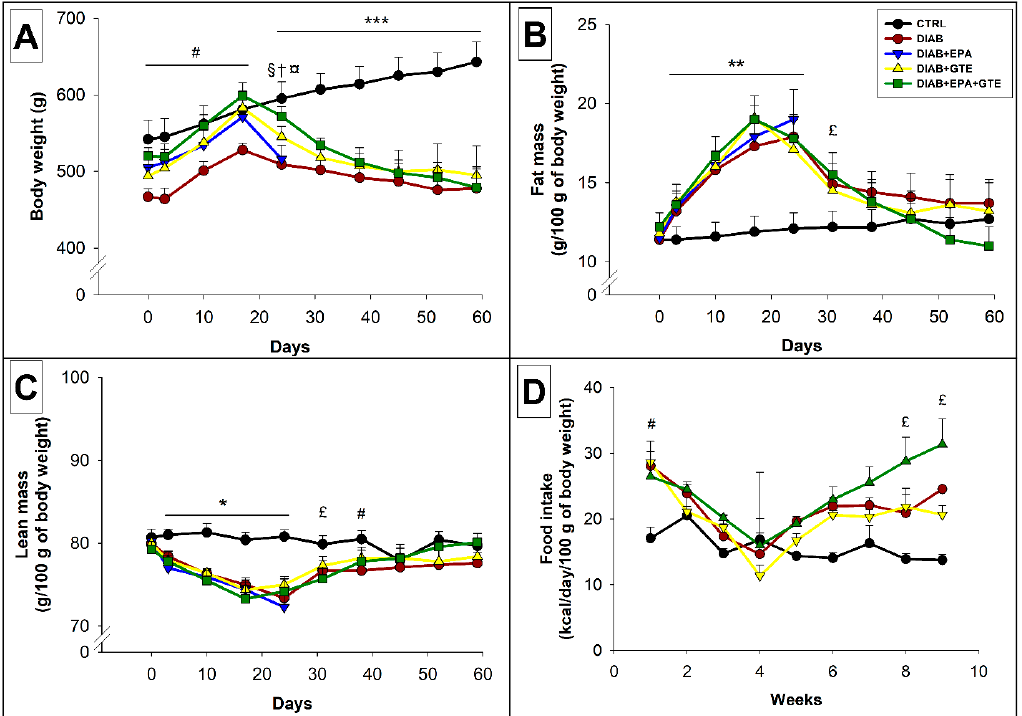
Figure 3. Morphological data and food intake. ( A ) Evolution of the body weight in the different groups; ( B ) Evolution of the fat mass in the different group; ( C ) Evolution of the lean mass in the different group; and ( D ) Rat food intake over the course of the study. CTRL: Control group; DIAB: Diabetic rats; GTE: Green tea extract enrichment; and EPA: Eicosapentaenoic acid enrichment. *: CTRL group different to the others groups; #: CTRL group different to the DIAB group; £: CTRL group different to the DIAB+EPA+GTE group; †: DIAB group different to the DIAB+GTE group; ¤: DIAB group different to the DIAB+EPA+GTE group; and §: DIAB+GTE group different to the DIAB+EPA+GTE group. One symbol: p < 0.05; two symbols: p < 0.01; and three symbols: p < 0.001.